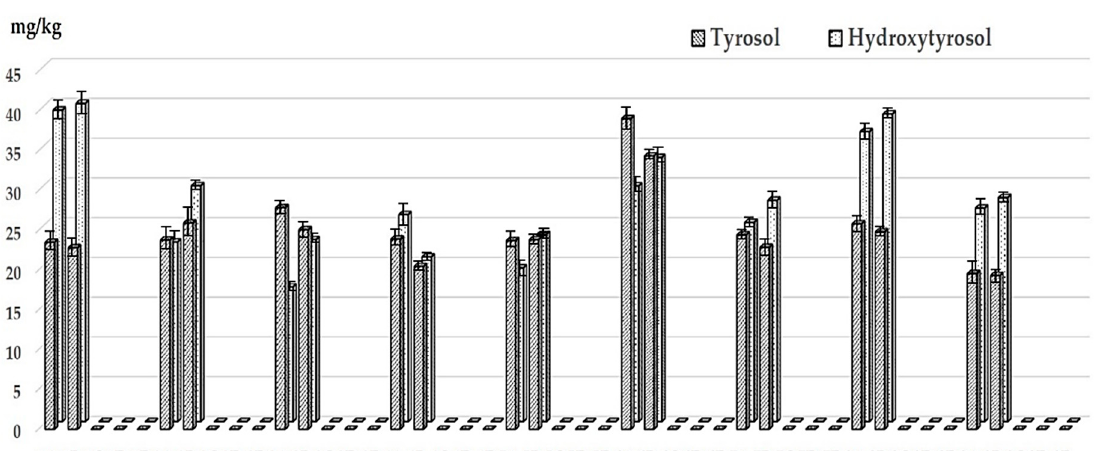
Figure 1. Effect of the refining steps on the hydroxytyrosol and tyrosol content (mg/kg oil). Legend for refining steps: A: Crude oil; B: degummed oil; C: neutralized oil; D: bleached oil; E: deodorized oil.